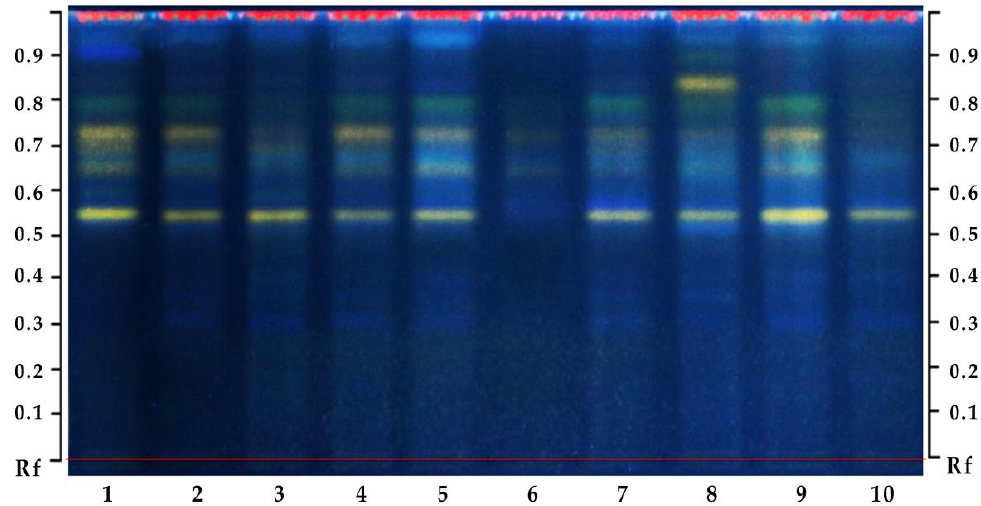
Figure A2. Chromatogram of methanol extracts of common oak leaves after inoculation of endo- phytic, phytopathogenic and epiphytic bacteria: 1 — control, 2 — Bacillus subtilis (Q2), 3 — Bacillus am- yloliquefaciens (Q7), 4 — Q2/Q7 (mix 1:1), 5 — Pectobacterium spp., 6 — Pseudomonas spp., 7 — Lelliottia amnigena (Q5), 8 — Delftia acidovorans (Q6), 9 — EpQ1, 10 — EpQ2.